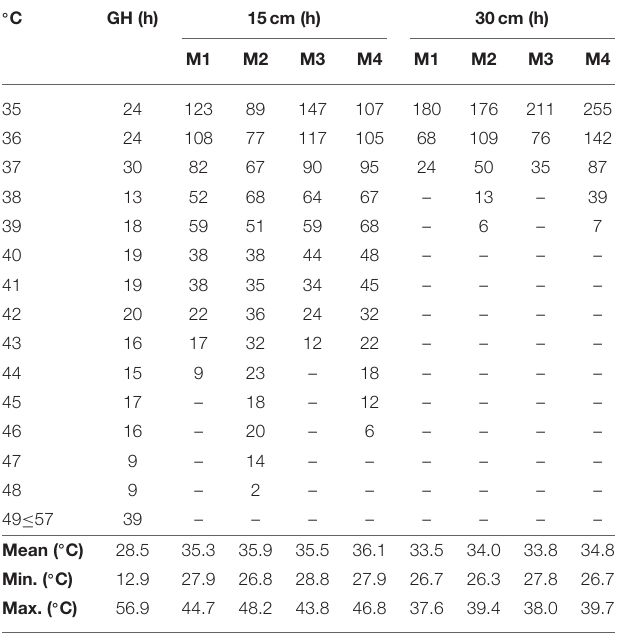
TABLE 4 | Number of hours accumulated during 6 weeks of biodisinfestation treatments at the different temperatures registered in the different soil depths (15 and 30cm) in one plot assigned to each treatment (M1, M2, M3, M4) and inside the greenhouse (GH).